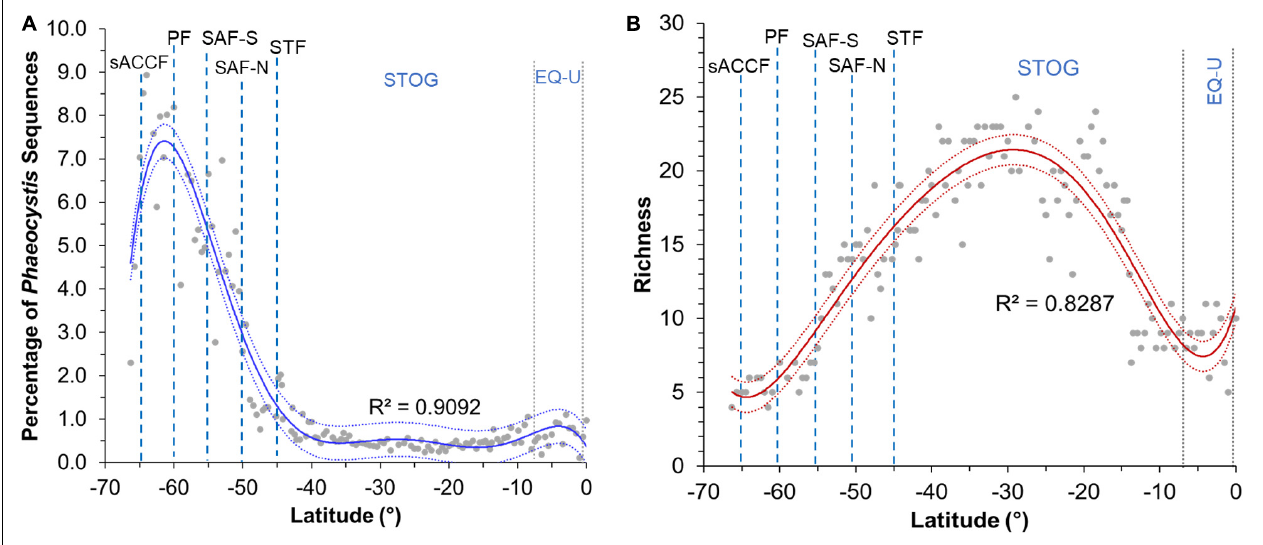
FIGURE 3 | Plot of (A) percentage of Phaeocystis sequences against latitude and (B) richness against latitude for sampling stations across all latitudes. Percentage values presented in plot A are calculated as average Phaeocystis relative abundance value per station (of the four sampled depths within the upper water column) against all microbial eukaryote 18S rRNA gene sequences per station (i.e., 25,000 sequences). Sixth-order polynomial fit is indicated by the blue line for the sequence percentage plot and by the red line for the richness plot. 95% confidence intervals are indicated by blue ( Phaeocystis sequence percentage plot) and red dotted lines (richness plot). Blue dashed lines indicate approximate location of fronts, gray dotted lines indicate approximate boundaries for subtropical gyre and equatorial upwelling zones. Acronyms for fronts and zones are as listed in Figure 1